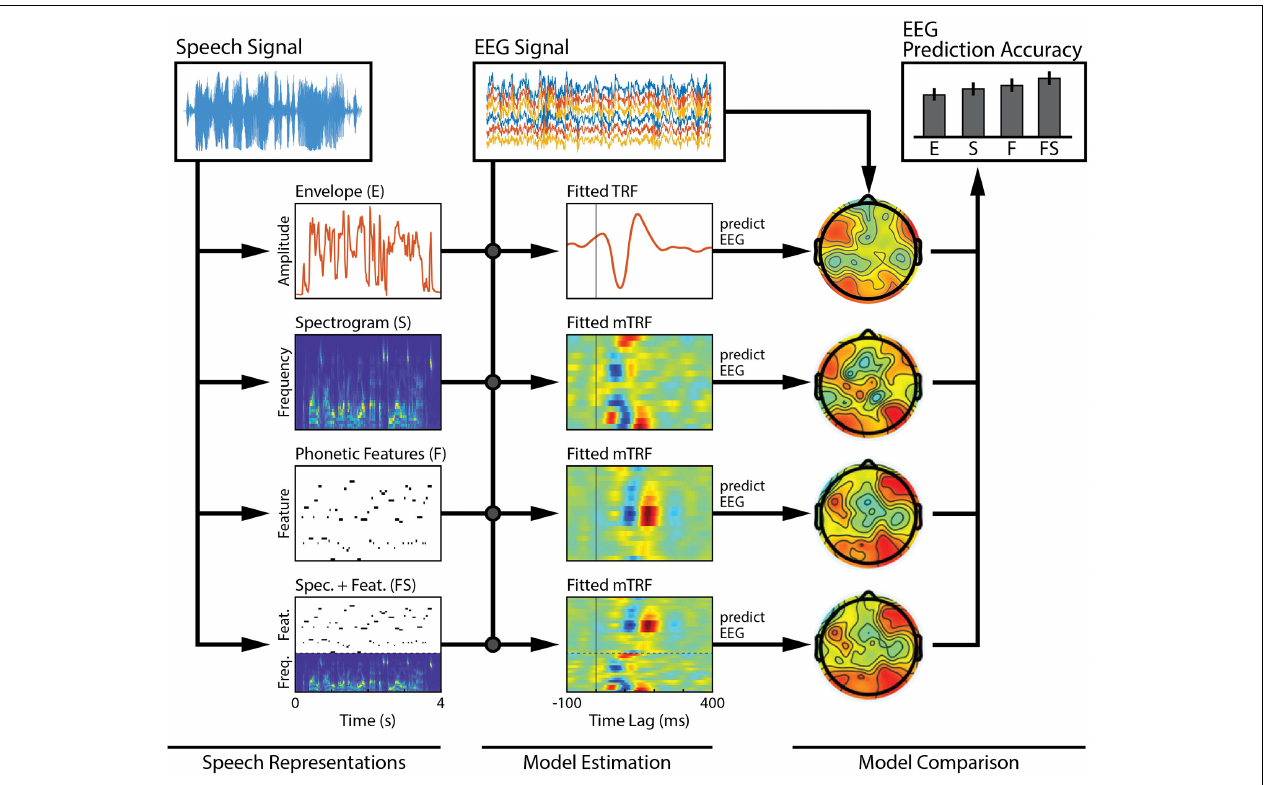
FIGURE 2 | Comparison across a family of models. Several features of interest are derived from our speech signal. Each of these features (or combinations of them) can be regressed against brain activity to estimate single- or combined-feature encoding models (TRFs). The TRFs can be used to predict held-out EEG data, channel-by-channel, and the accuracy of those predictions can be measured to assess the quality of the model. Here, we compare model performance across a set of six bilateral auditory-responsive electrodes (Di Liberto et al., 2015).